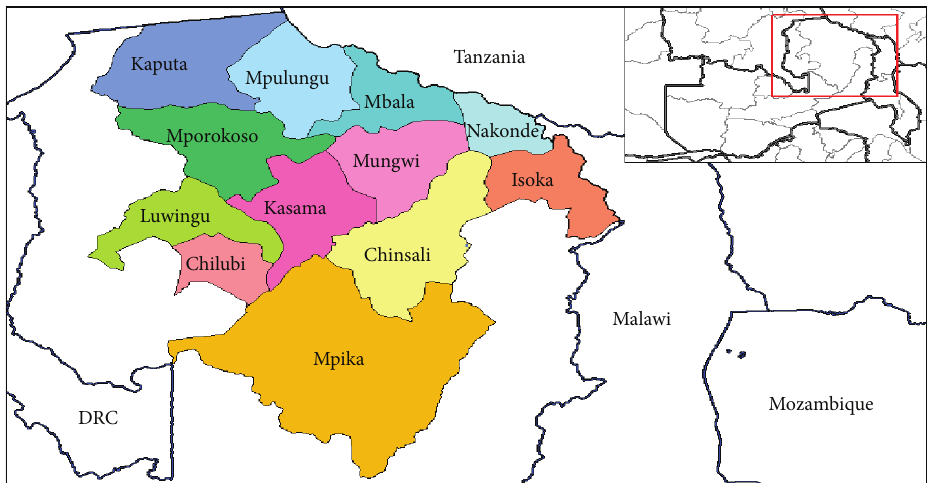
Figure1:LocationofMpulungu,Mbala,andNakondeinrelationtootherdistrictsofNorthernZambiaandTanzaniaonNorthWest.Tanzania is located in the